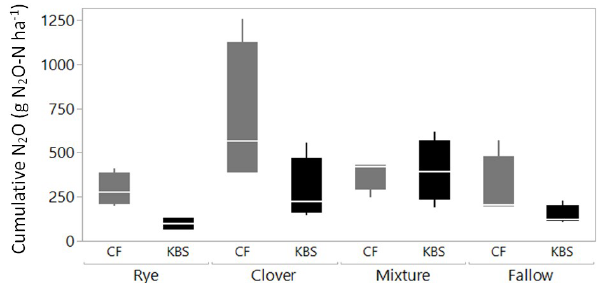
Figure 4. Cumulative N 2 O flux by treatment, compared between